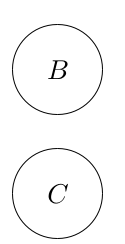
Figure 20 . Diagrammatic representation of the six terms in (4.6). These can also be interpreted as cuts of (cid:12)gure 19(a).